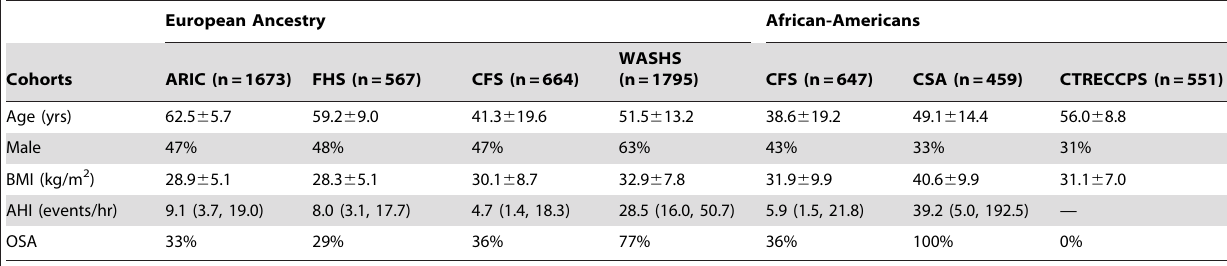
European Ancestry African-Americans